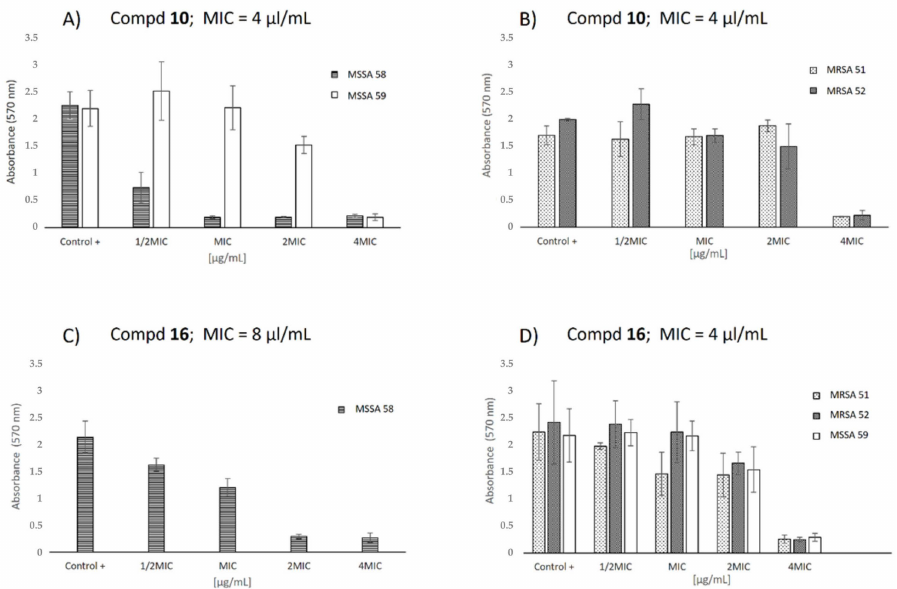
Figure 1. Biofilm inhibition in selected S. aureus strains by compounds 10 and 16 . Values represent mean ± SD of three independent